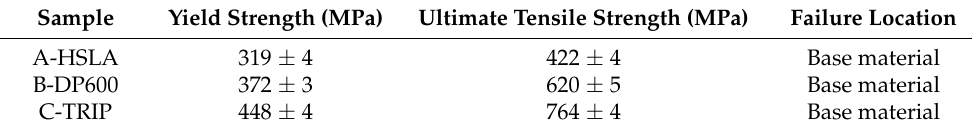
Table 4. Average values of experimental steel tensile